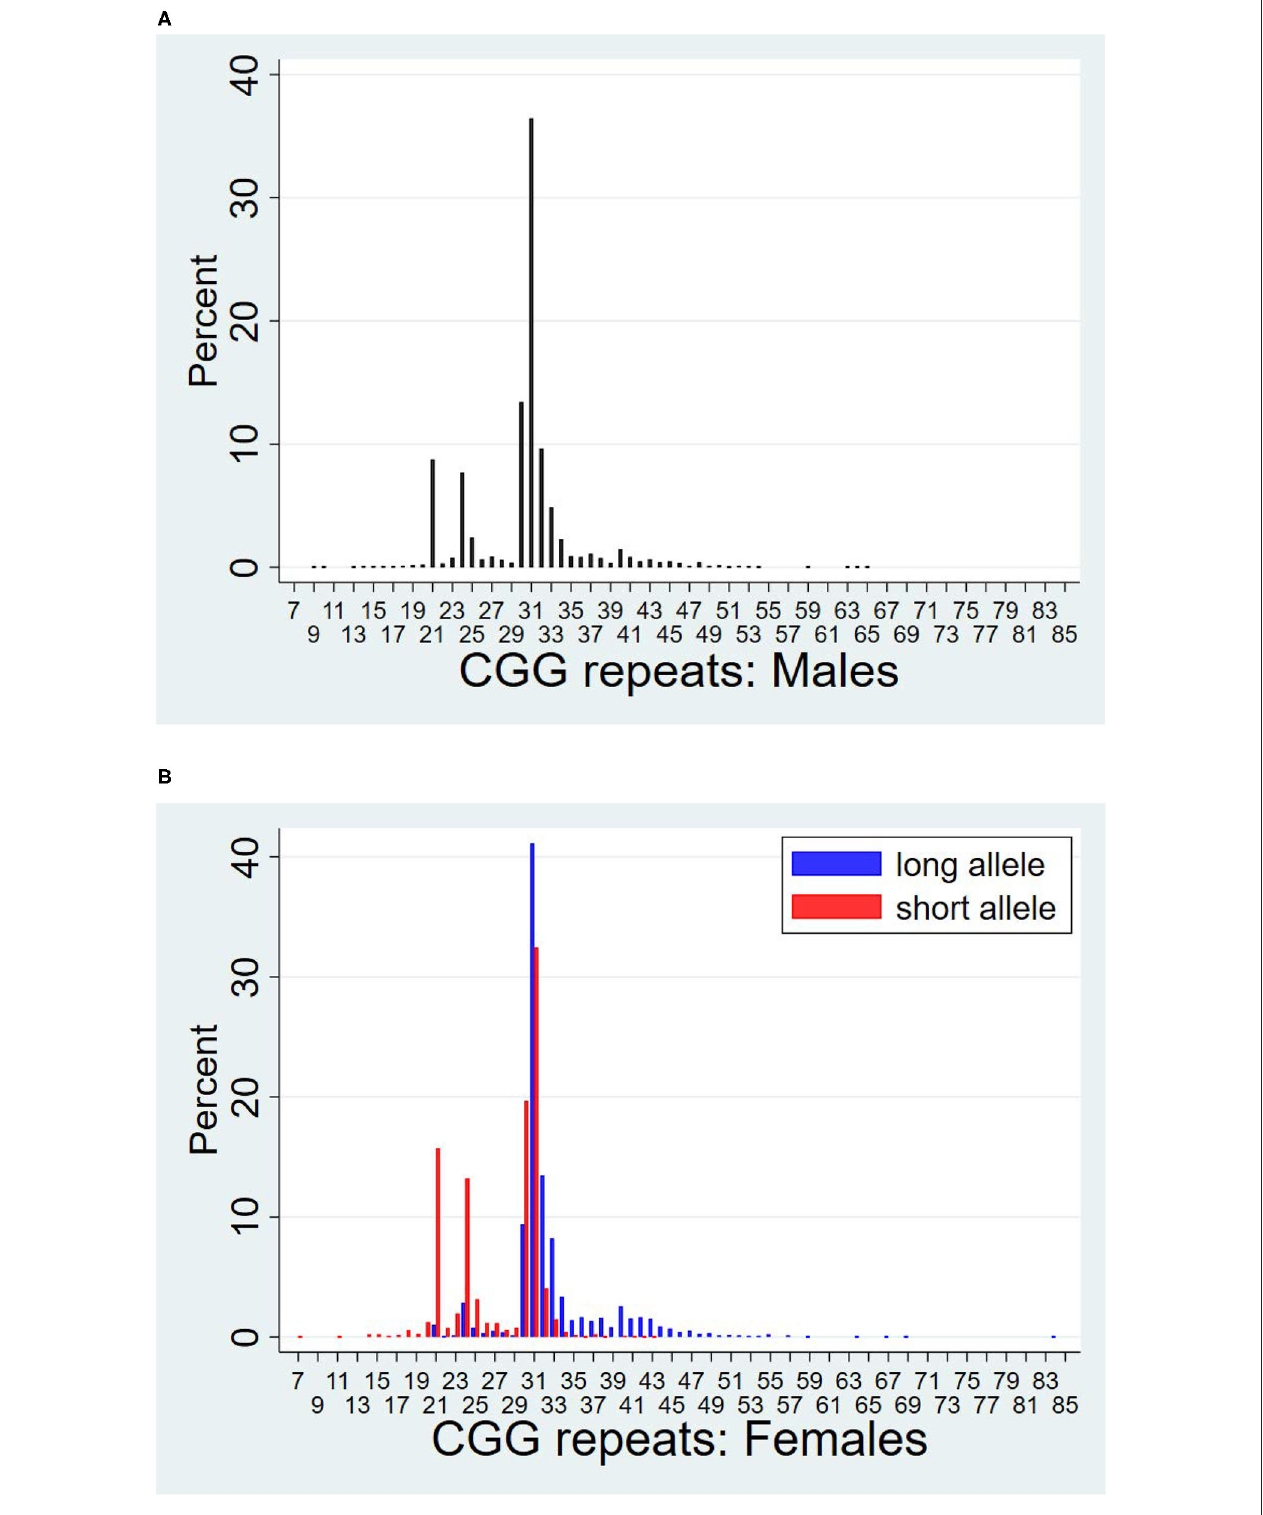
FIGURE 1 | Distributions of CGG repeat lengths by sex. (A) Males. (B) Females.